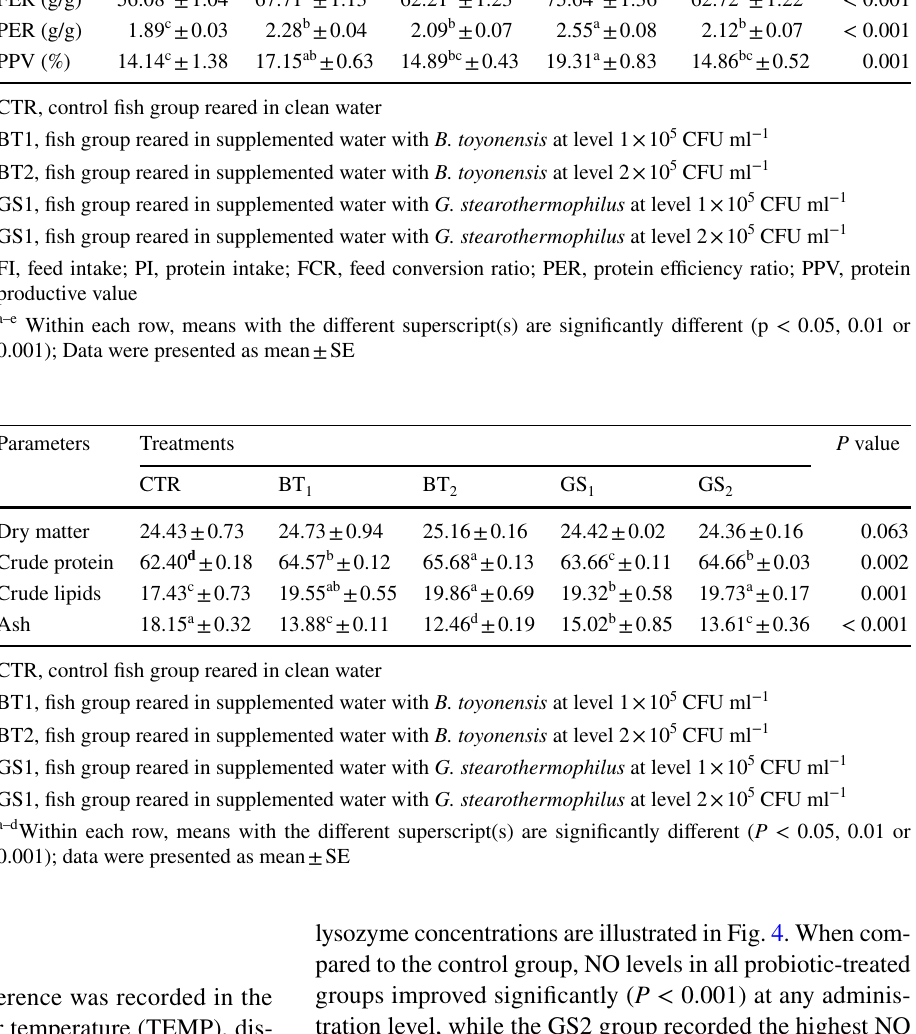
Table 3 Feed utilization measurements of tilapia fish reared in treated water with or without probiotics for 70 days